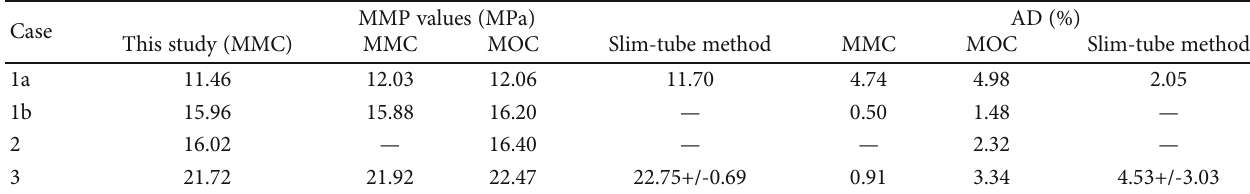
Table 3: The comparison of MMP values from this study and the